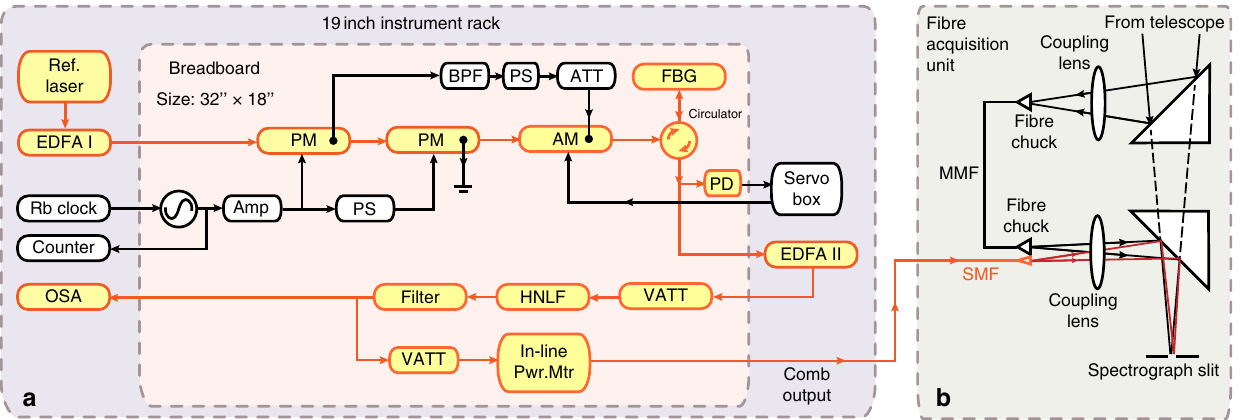
Figure 2 | Detailed set-up of line-referenced electro-optical frequency comb. ( a ) The entire LR-EOFC system sits in a 19inch instrument rack. Optics and microwave components in the rack are denoted in orange and black, respectively. Small components were assembled onto a breadboard. These included the phase modulators (PM), amplitude modulator (AM), fibre Bragg grating (FBG), photodetector (PD), variable attenuator (VATT), attenuator (ATT), highly nonlinear fibre (HNLF), microwave source, microwave amplifier (Amp), phase shifter (PS) and band-pass filter (BPS). The reference laser, erbium- doped fiber amplifier (EDFA), rubidium (Rb) clock, counter, optical spectrum analyser (OSA) and servo lock box are separately located in the instrument rack. ( b ) A simplified schematic of the fibre acquisition unit (FAU) is also shown. Stellar light is focused and coupled into a multimode fibre (MMF). The comb light from a single mode fibre (SMF), together with the stellar light in the MMF, are focused on the spectrograph slit and sent into the spectrograph.